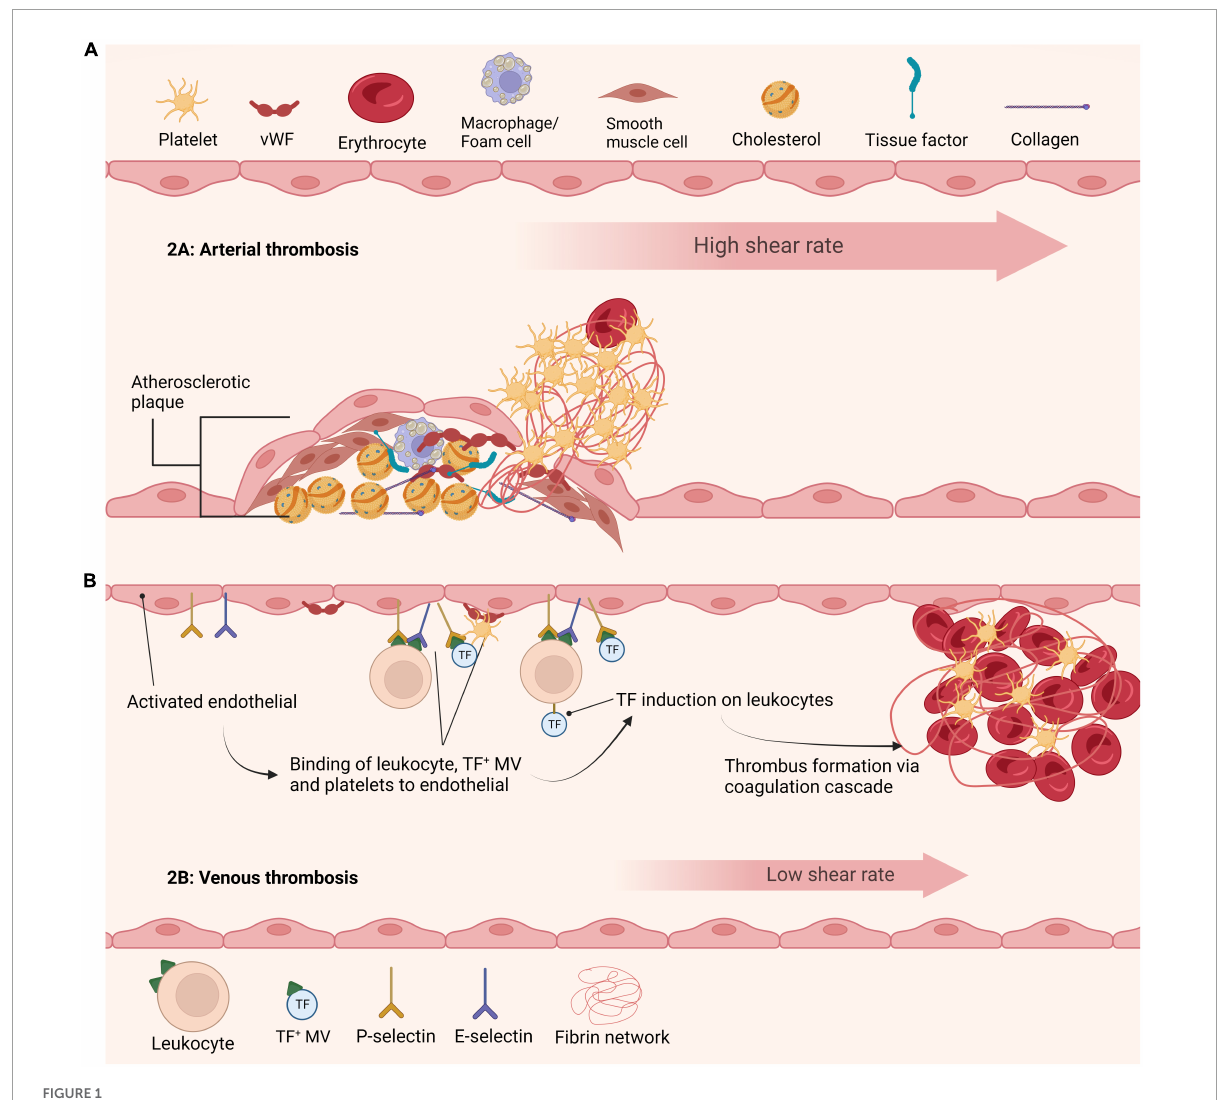
FIGURE1 Current understanding of arterial and venous thrombi initiation. (A) Initiation of arterial thrombus formation is triggered by atherosclerotic plaque rupture. Exposure of collagen and tissue factor leads to recruitment and activation of platelets at the site of injury. Thrombi in arteries are formed under high shear stress and are rich in platelets. (B) Formation of venous thrombi is currently understood to be triggered by various mechanisms. The activated endothelium leads to recruitment and binding of cells and factors including leukocytes, tissue factor positive microvesicles and platelets. These agents further promote tissue factor recruitment ultimately leading to formation of a venous